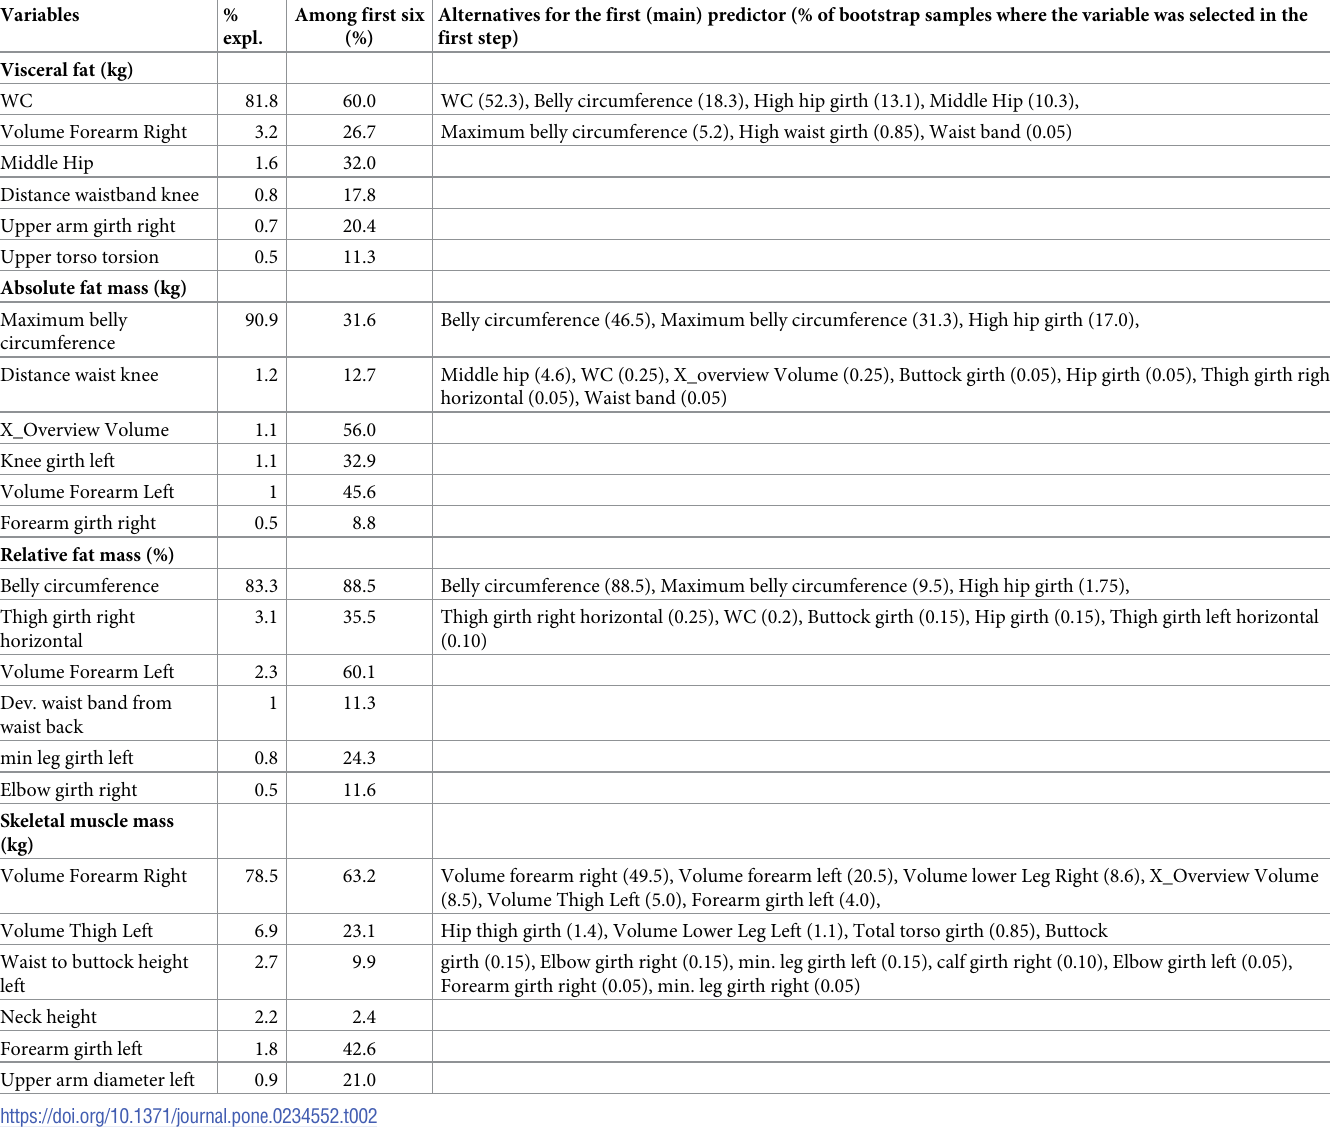
Table 2. Detailed results of stepwise forward model selection for the prediction of body composition (fat or muscle mass as estimated through bioimpedance analy- sis) from scanned anthropometric measurements. For each of the six measurements selected first in the stepwise procedure, the (additional) fraction of variation in body fat or muscle mass explained by the inclusion of this predictor in the model is given. The stability of model selection was evaluated by running the procedure on 2000 bootstrap samples. For each of the six measurements initially selected first, the fraction of bootstrap samples where this measurement was also among the first six predictors selected is given. In addition, all measurements that were selected in the first step at least once are